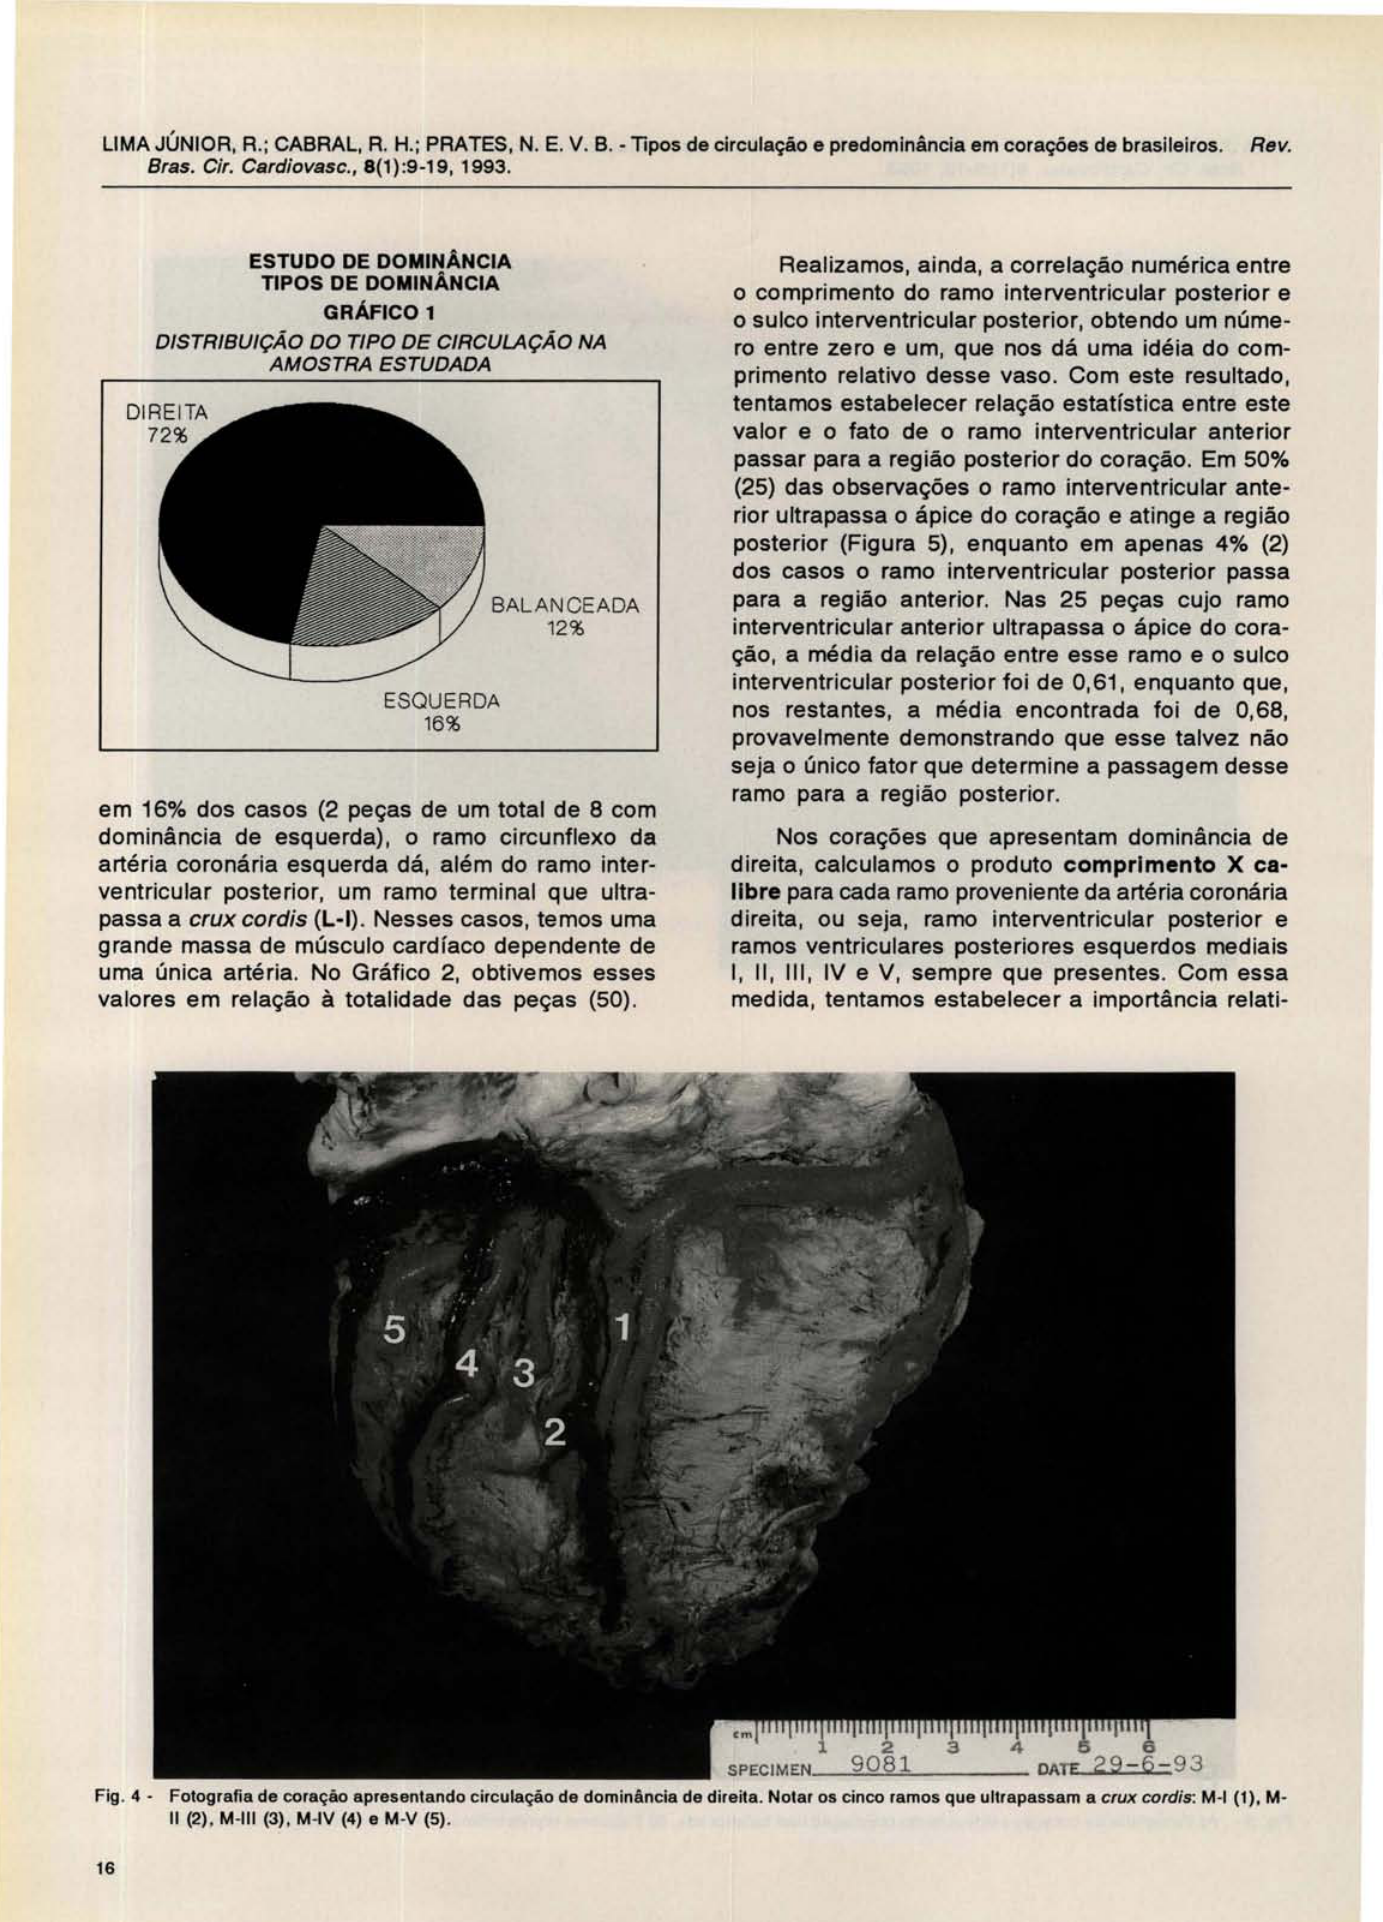
Fig. 4 - Fotografia de coração apresentando circulação de dominância de direita. Notar os cinco ramos que ultrapassam a crux cordis: M-I (1), M Il (2). M-III (3). M-IV (4) e M-V